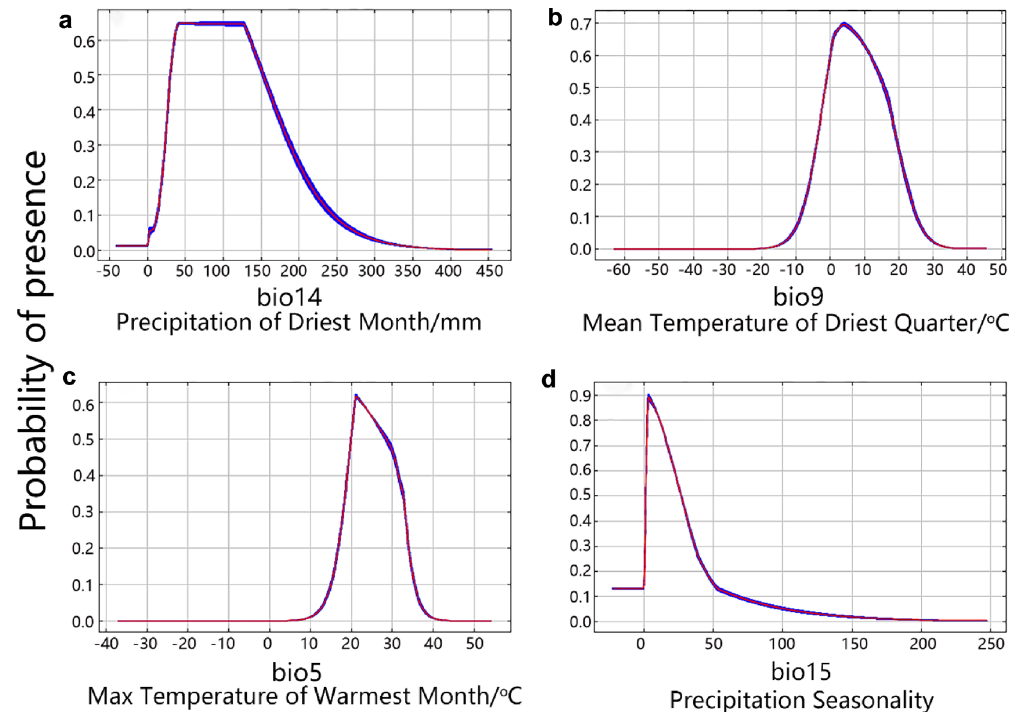
Figure 4. Response curve showing the relationships between the probability of the presence of N. alata and the key four bioclimatic variables. ( a ) response curve of N. alata to precipitation of driest month (bio14), ( b ) response curve of N. alata to mean temperature of driest quarter (bio9), ( c ) response curve of N. alata to max temperature of warmest month (bio5), ( d ) response curve of N. alata to precipitation seasonality (bio15). The probability values shown are the average over 10 replicate runs. Blue margins show ± SD (standard deviation) calculated over 10